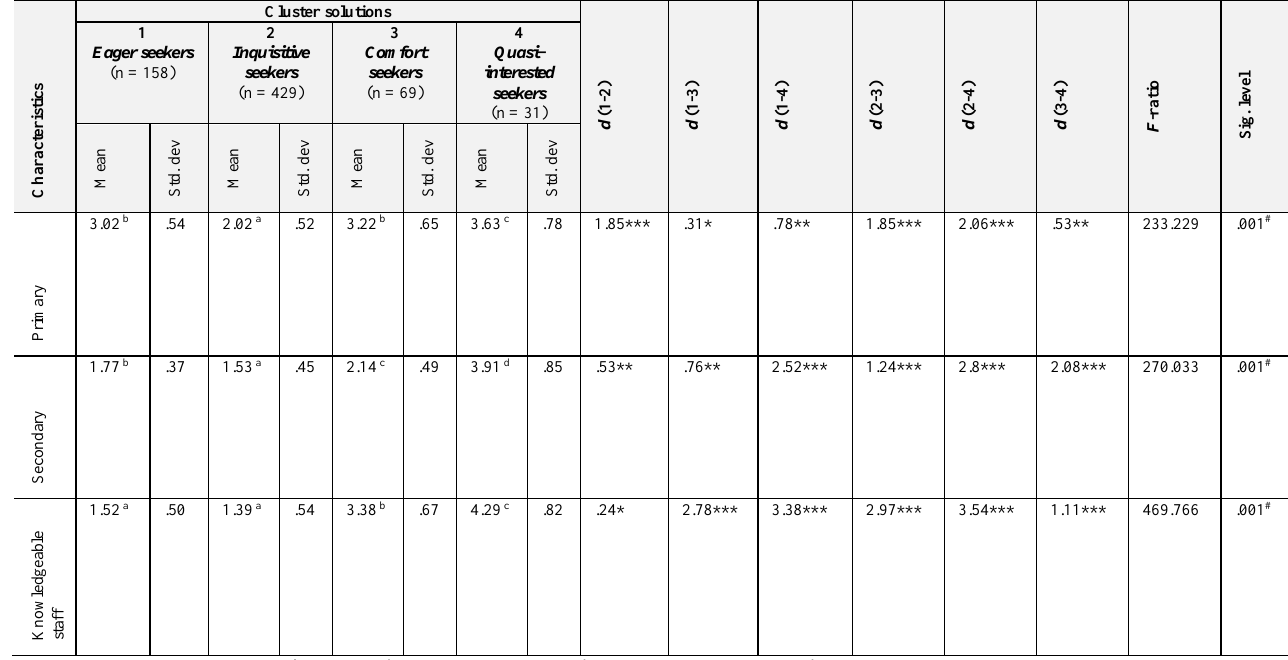
Table 3: ANOVAs for expected interpretation Cluster